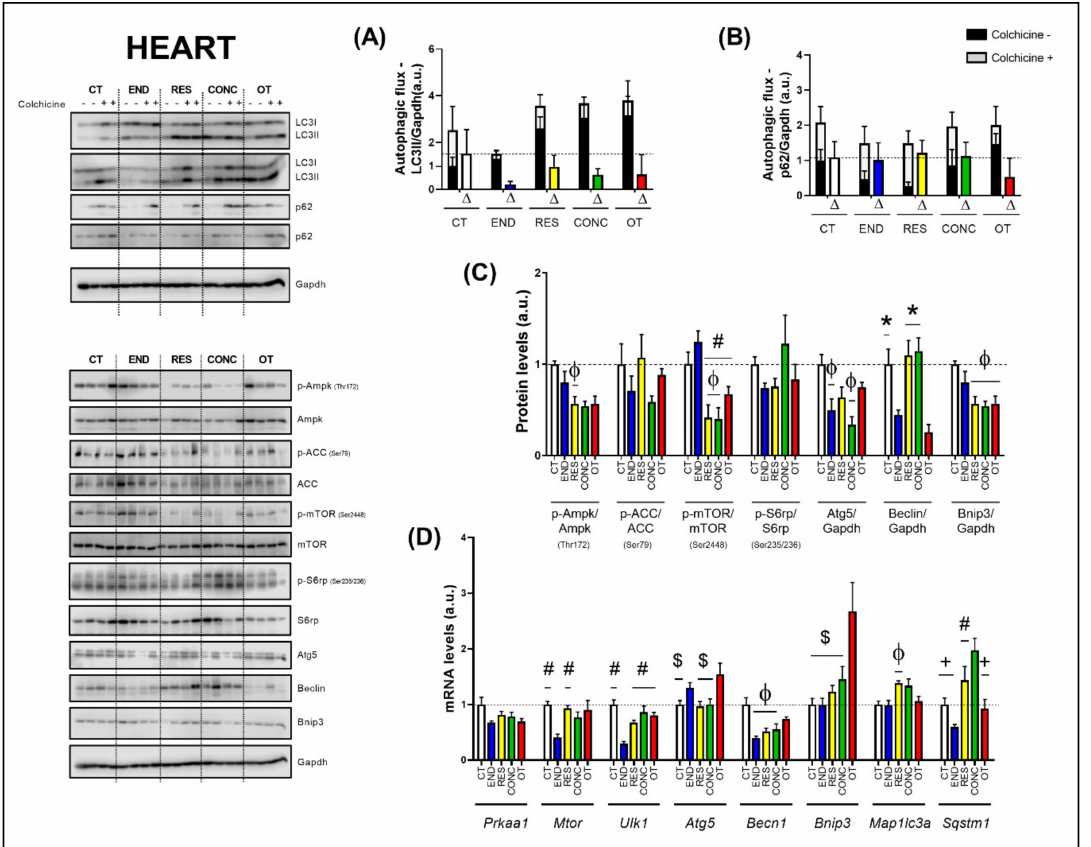
Figure 5. Autophagic flux for LC3II / Gapdh ( A ) and p62 / Gapdh ( B ) in the heart. Protein levels of p-Ampk / Ampk, p-ACC / ACC, p-mTOR / mTOR, p-S6rp / S6rp, Atg5 / Gapdh, Beclin / Gapdh, Bnip3 /